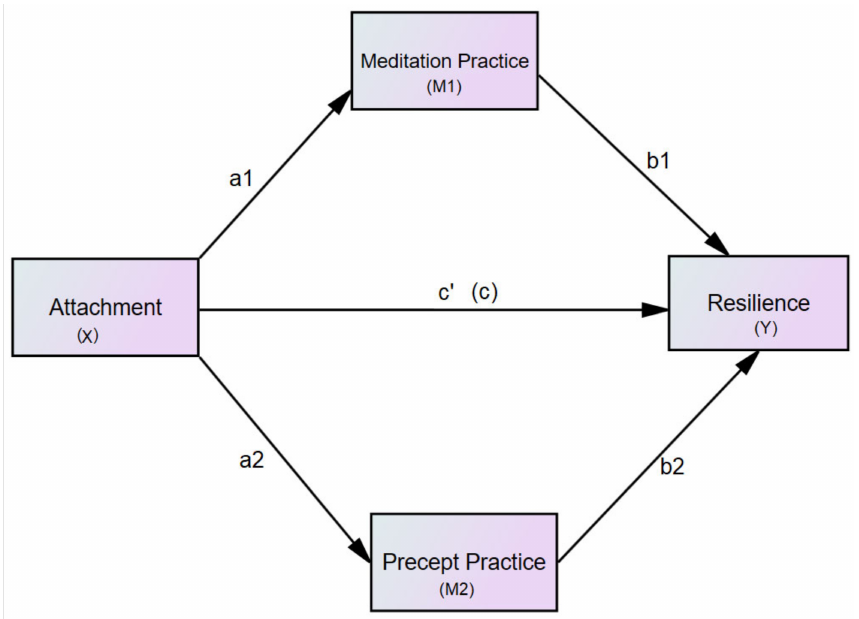
Figure 1. The hypothesized model. Notes: Path diagram illustrating the direct effects and causal paths linking attachment and resilience. a1, a2, b1, b2, c, and c’ = path coefficient (standardized coefficient), x = antecedent variable, M1 = mediator 1, M2 = mediator 2, Y =